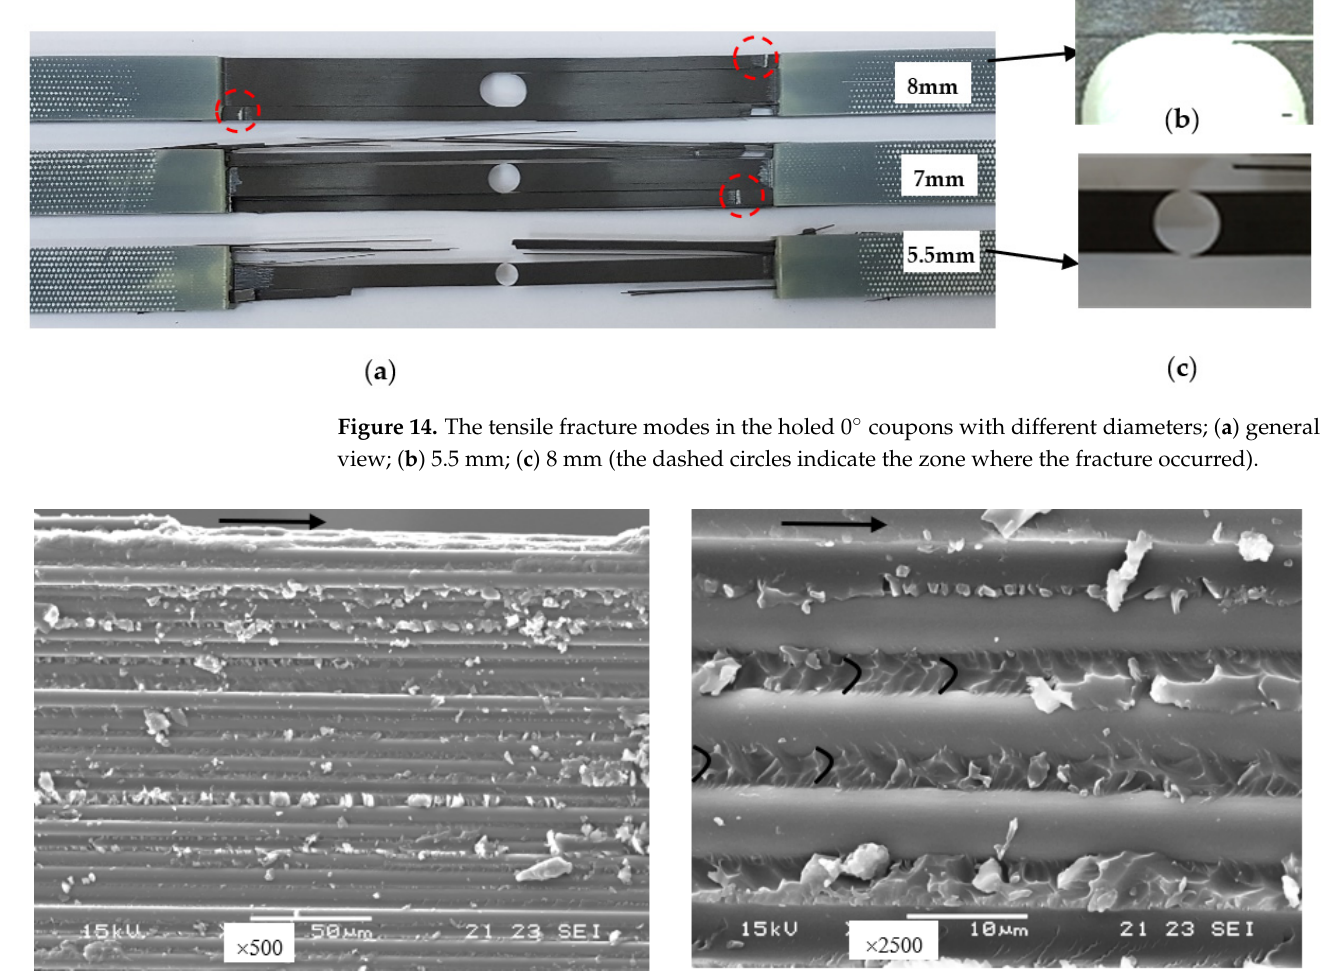
Figure 15. Microscopic fracture mode developed during tensile of holed coupons; ( a ) general view; ( b ) the chevron-type cracking of the epoxy resin between the carbon fibers.